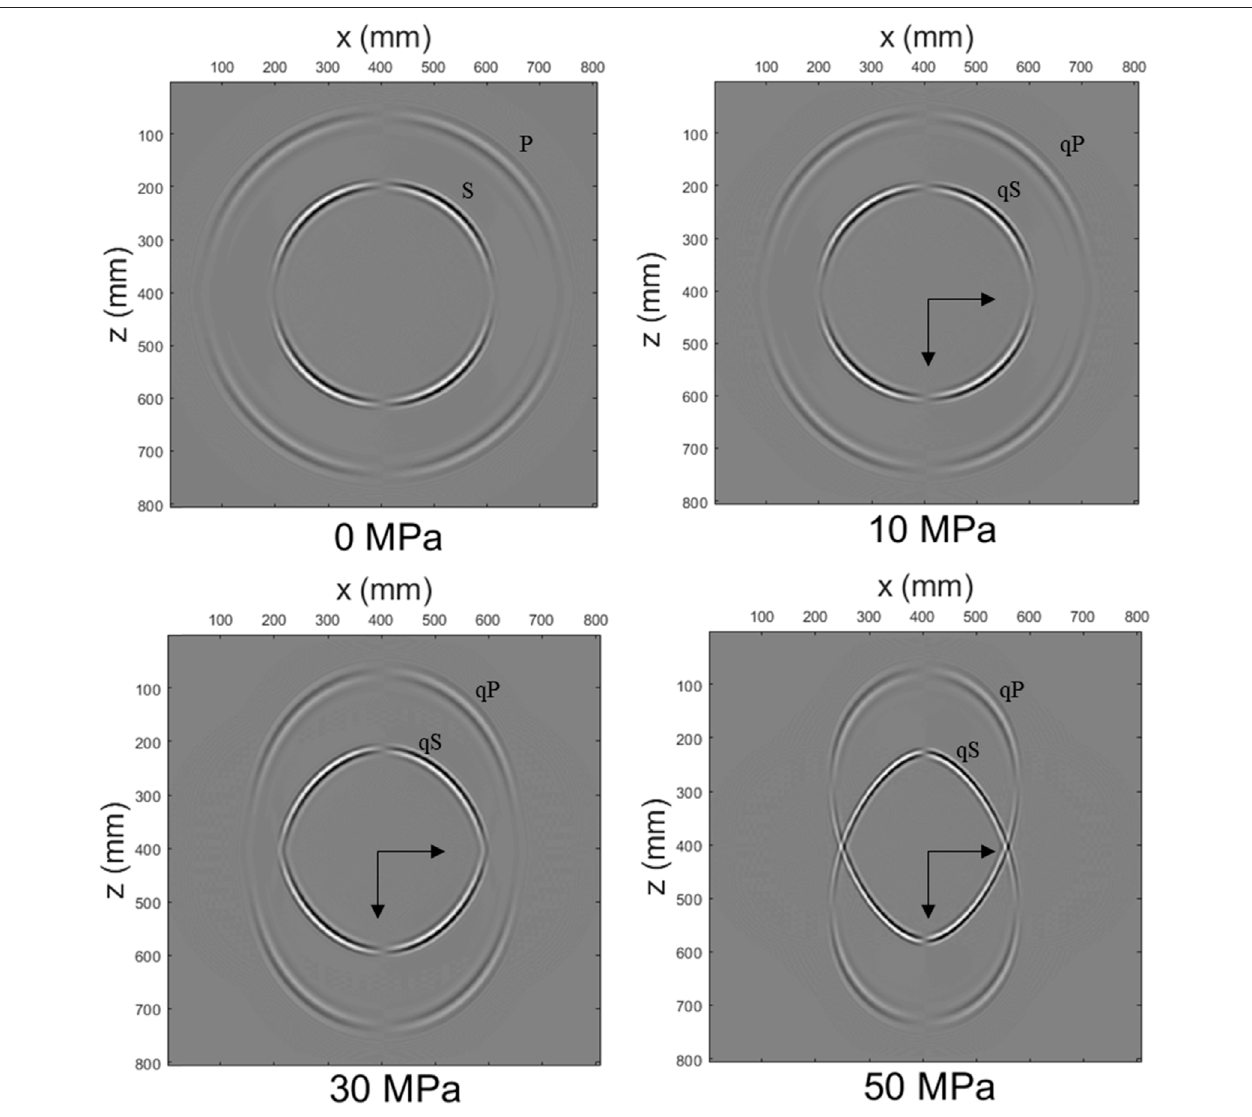
FIGURE 7 | Wave fi eld snapshots of the x -component of the particle velocity at t = 0.12 ms for various uniaxial stresses. The arrow indicates the principal strain direction calculated by Eq. 45 .